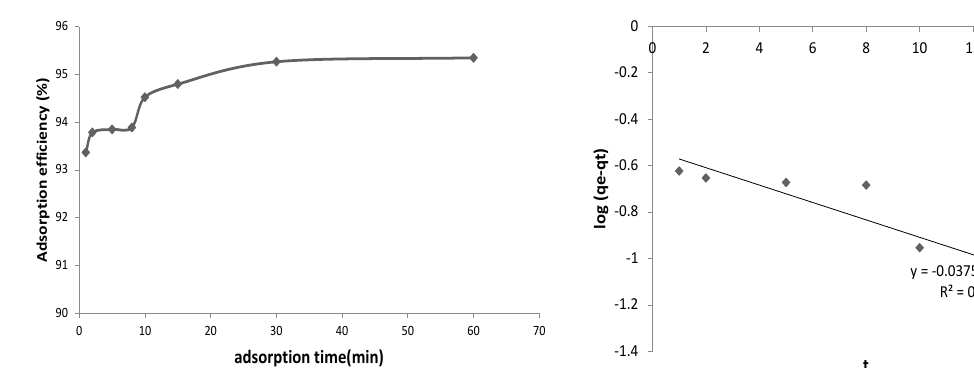
Fig. 5. Effect of adsorption time on adsorption efficiency of Amido Black 10B dye onto Polyaniline nano-adsorbent Fig. 6. Pseudo-first-order plot of Amido Black 10B adsorption onto Polyaniline nano-adsorbent